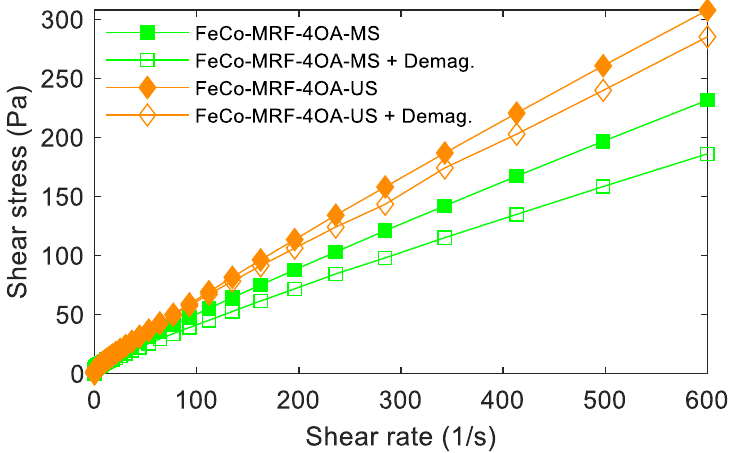
Figure 5. Reversibility behaviour was observed for the MRFs fabricated with the maximum amount of oleic acid (-4OA). Curves measured at 0 kA/m applied magnetic field (full symbols) and after applying 616.7 kA/m, plus the subsequent demagnetization process to reach a zero magnetic field (open symbols).